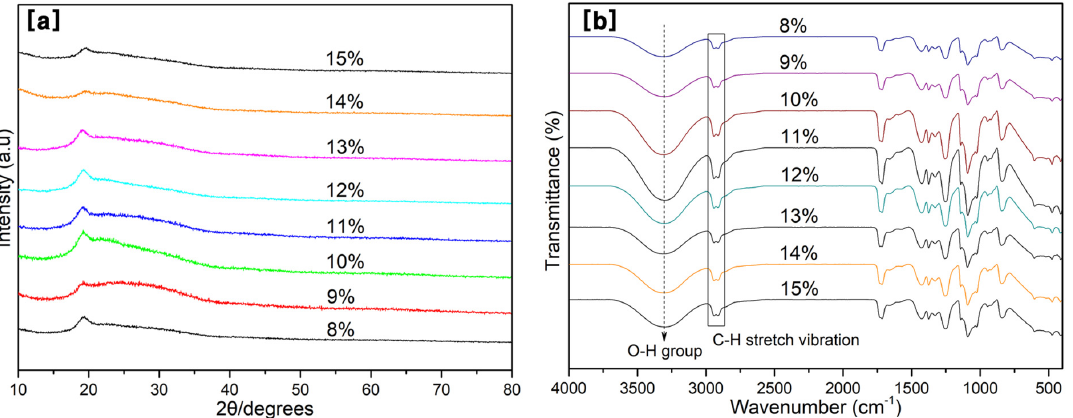
Figure 7. XRD ( a ) and FT-IR ( b ) analysis for all PVA membranes. Table 2. Main FTIR peaks for the PVA nanofiber membrane.